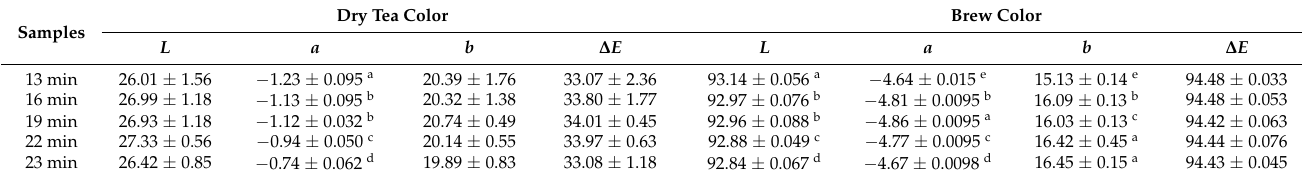
Table 2. Color quality scores of the YAYT with different roasting times.